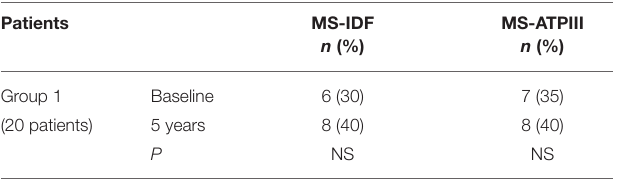
TABLE 6 | The prevalence of metabolic syndrome (MS) in patients (group 1) at study entry and after 5-year follow-up.